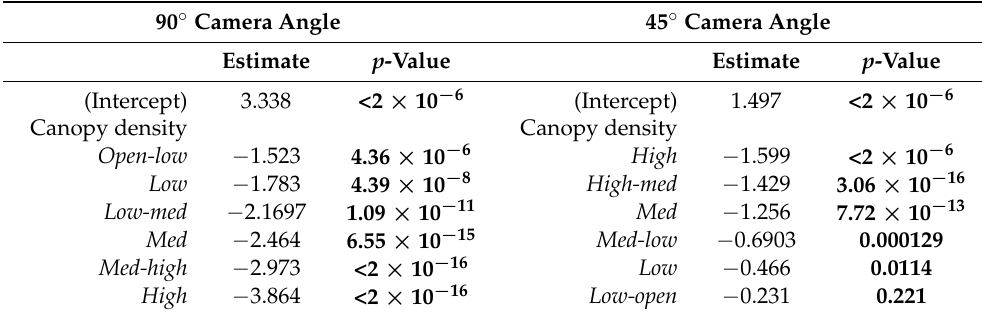
Table A3. A summary of coefficients and p -values showing the effect of canopy density on detection with different camera angles for TIR data with manual analysis.